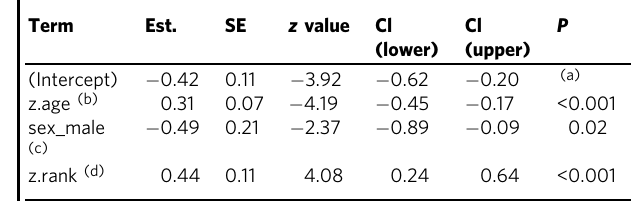
Table 1 In fl uence of age and sex on the production of agonistic signals (model 1).